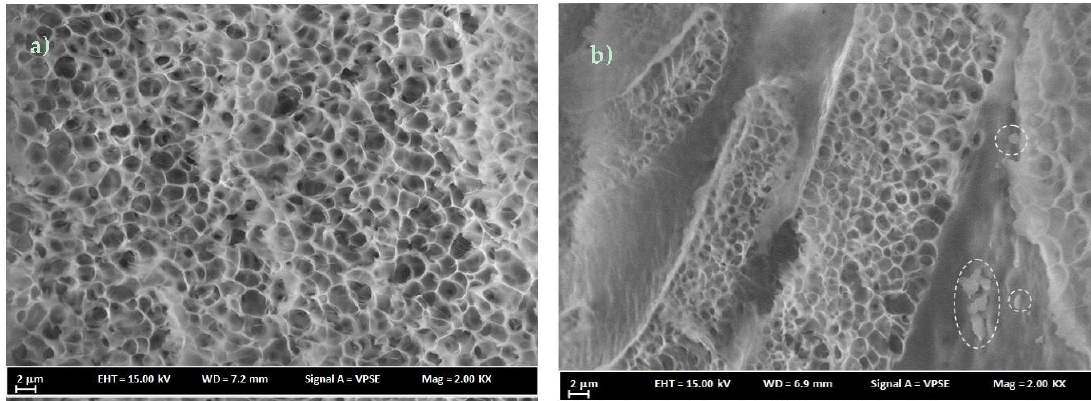
Figure 7. FESEM cross-sectional images of membranes ( a ) 16 wt % PC/NMP and ( b ) 18 wt % PC/NMP, the traces of residual solvent are shown by the circled area.